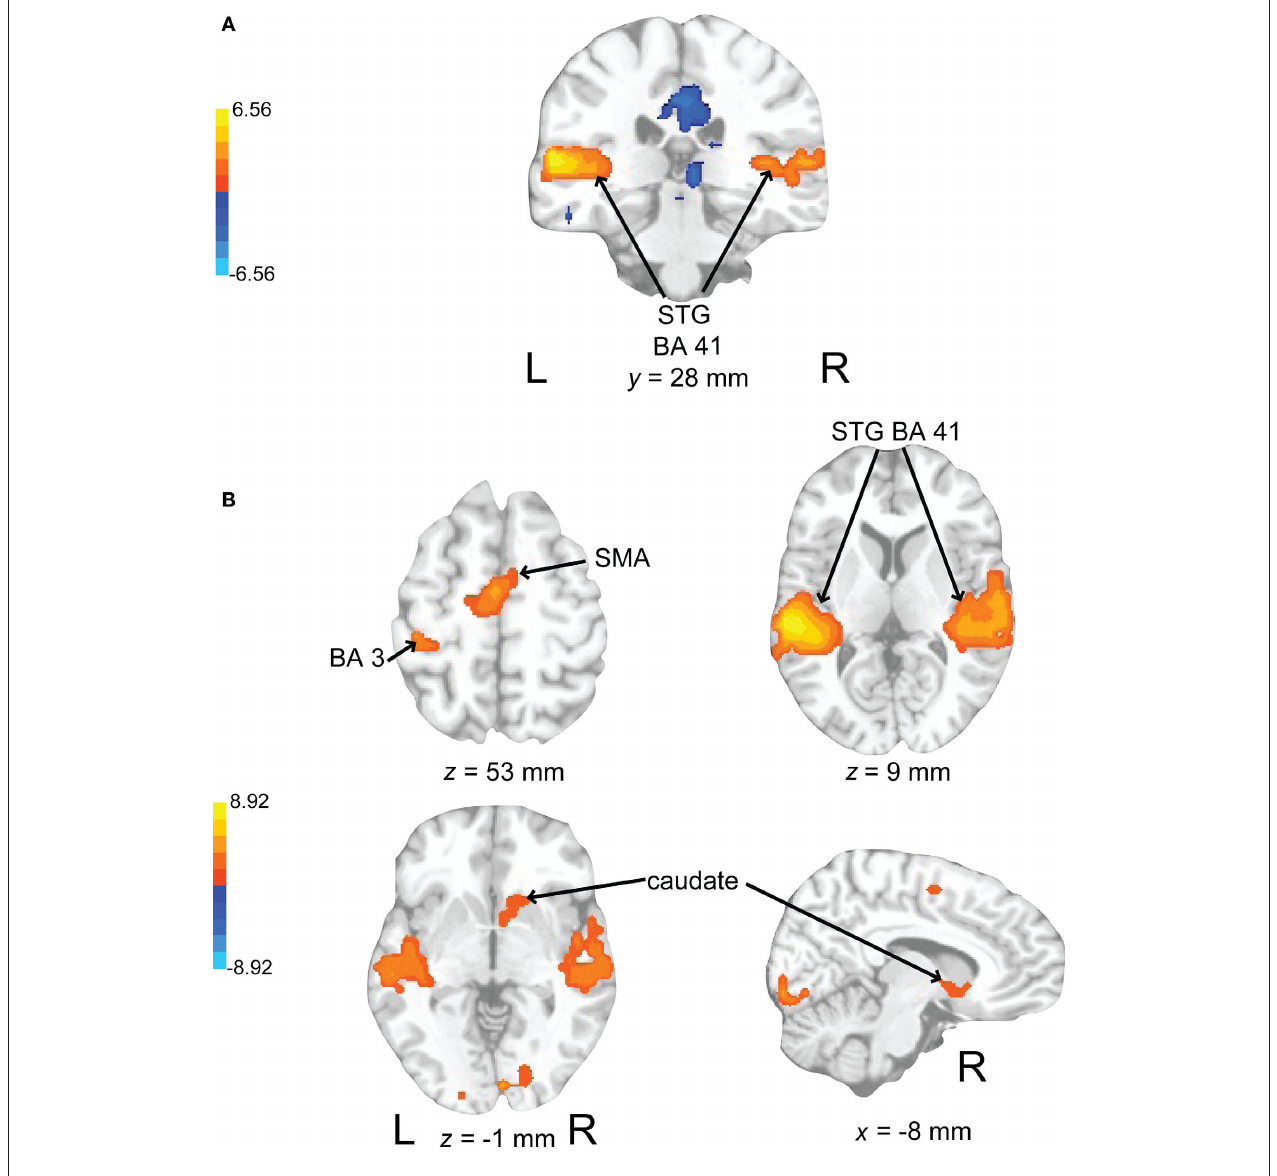
FIguRe 6 | Brain regions where BOLD signal was significantly different during (A) the auditory attend 1 condition compared to rest ( p < 0.002 corrected) and (B) auditory attend 2 compared to rest. Red to yellow colored voxels represent brain areas where auditory attend 1 > rest and attend 2 > rest.